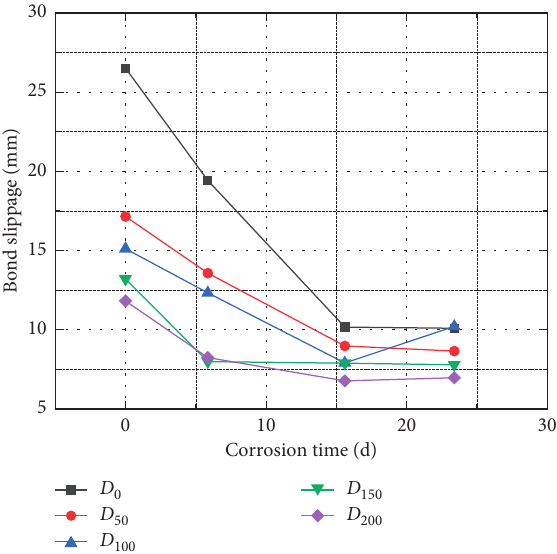
Figure 8: The change of bond